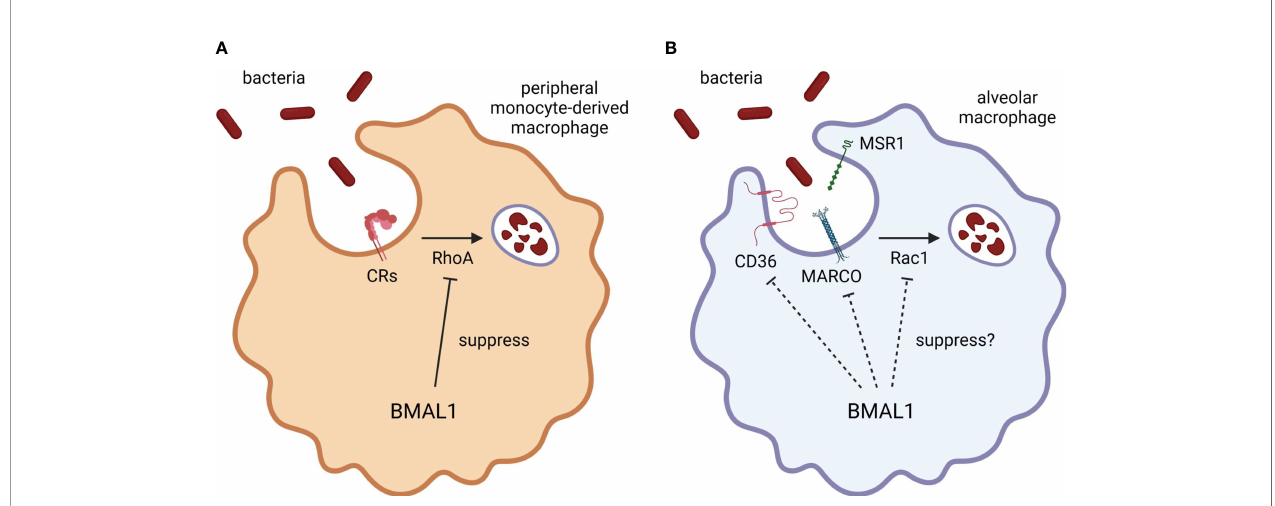
FIGURE 2 | BMAL1 regulation of macrophage phagocytosis. BMAL1 suppresses bacterial phagocytosis by inhibiting RhoA activation in monocyte/macrophage lineage. (A) CRs require RhoA activation to engulf the antigens. Since peripheral monocytes express CR3, the phagocytic activity of peripheral monocyte-derived macrophages may be strongly regulated by BMAL1. (B) Although the phagocytic activity of alveolar macrophages is also improved by BMAL1 deletion, BMAL1 may regulate the expression of scavenger receptors or other signaling components as alveolar macrophages hardly express CRs. Thus, misaligned circadian rhythms may disturb the autonomic control of macrophage phagocytosis by disrupting temporal variation of BMAL1 expression. CR, complement receptor; BMAL1, brain and muscle ARNT-like 1; MARCO, macrophage receptor with collagenous structure; MSR1, macrophage scavenger receptor 1; Rac1, Ras-related C3 botulinus toxin substrate 1; RhoA, Ras homolog family member